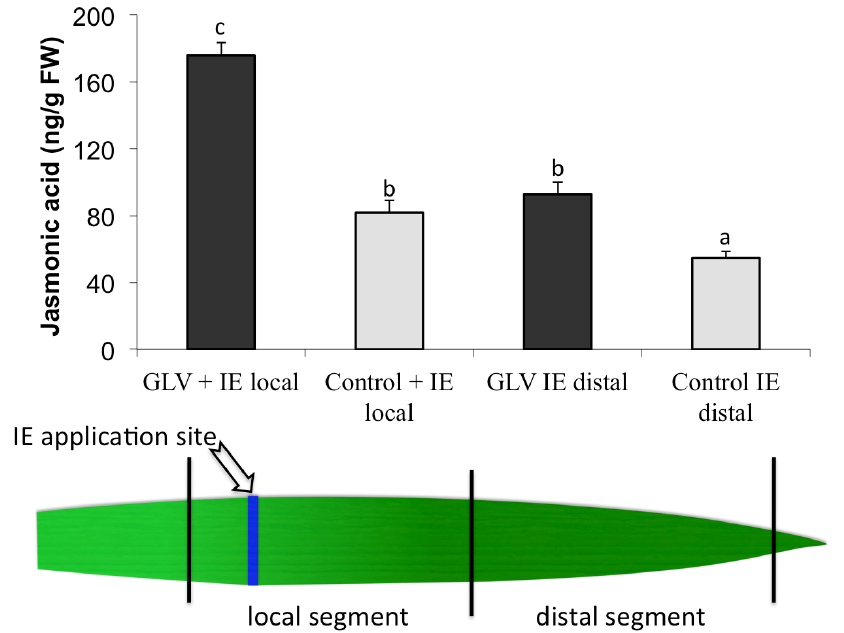
Figure 1. Effect of Z -3-hexenol (GLV) priming on local and distal jasmonic acid (ng·gFW −1 ) accumulation after treatment with insect elicitor (IE). Plants were exposed to 10 μg of GLV for 16 h and then IE for 1 h. Controls were treated similarly, but without GLV. Jasmonic acid was analyzed by GC/MS as described in [19,34,45]. Different letters above each bar indicate statistical difference determined by ANOVA analysis followed by Tukey tests where appropriate ( p < 0.05). N = 4, error bars represent standard deviation.